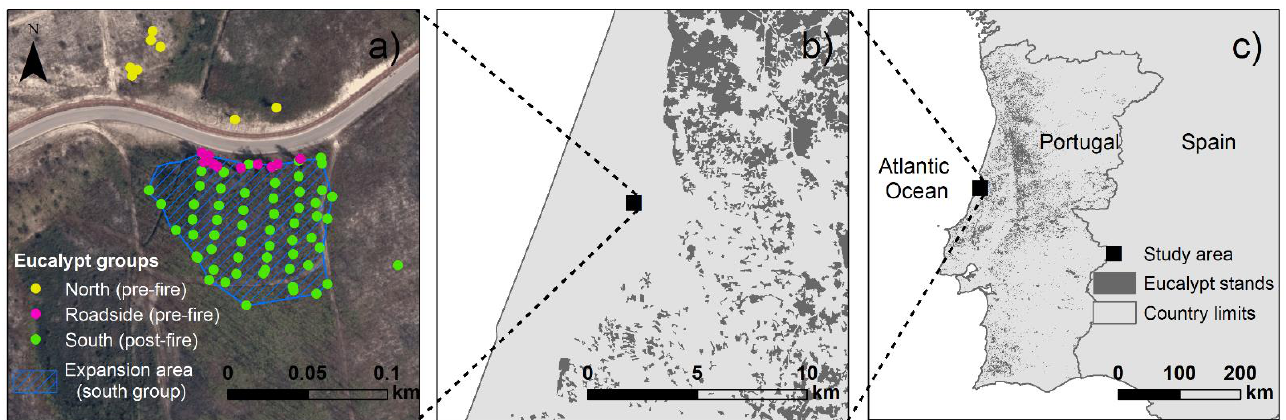
Figure 1. Location of sampled eucalypts ( n = 78) in the study area according to eucalypt groups ( a ), relative to surrounding eucalypt stands ( b ), in central Portugal ( c ). Eucalypt groups include: “north”—pre-fire eucalypts established north of the road; “south”—post-fire eucalypts established south of the road; roadside—large pre-fire eucalypts established on the roadside. Geographical information (orthophoto 2018) in ( a ) provided by Direção-Geral do Território.